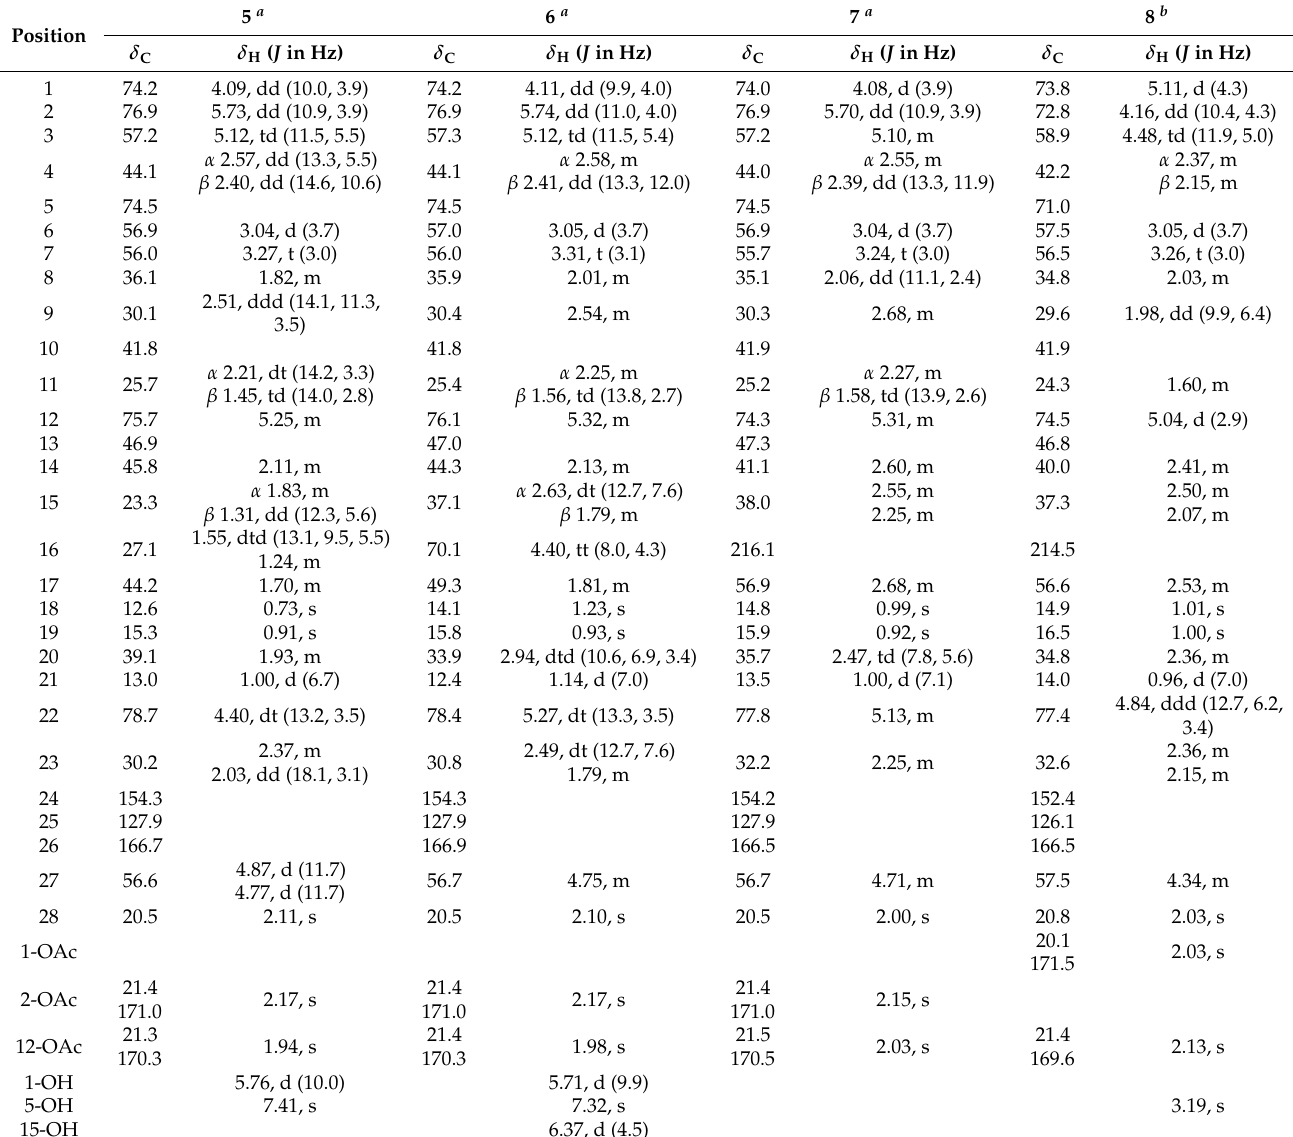
Table 2. 1 H and 13 C NMR data for compounds 5 – 8 ( δ in ppm, J in Hz).